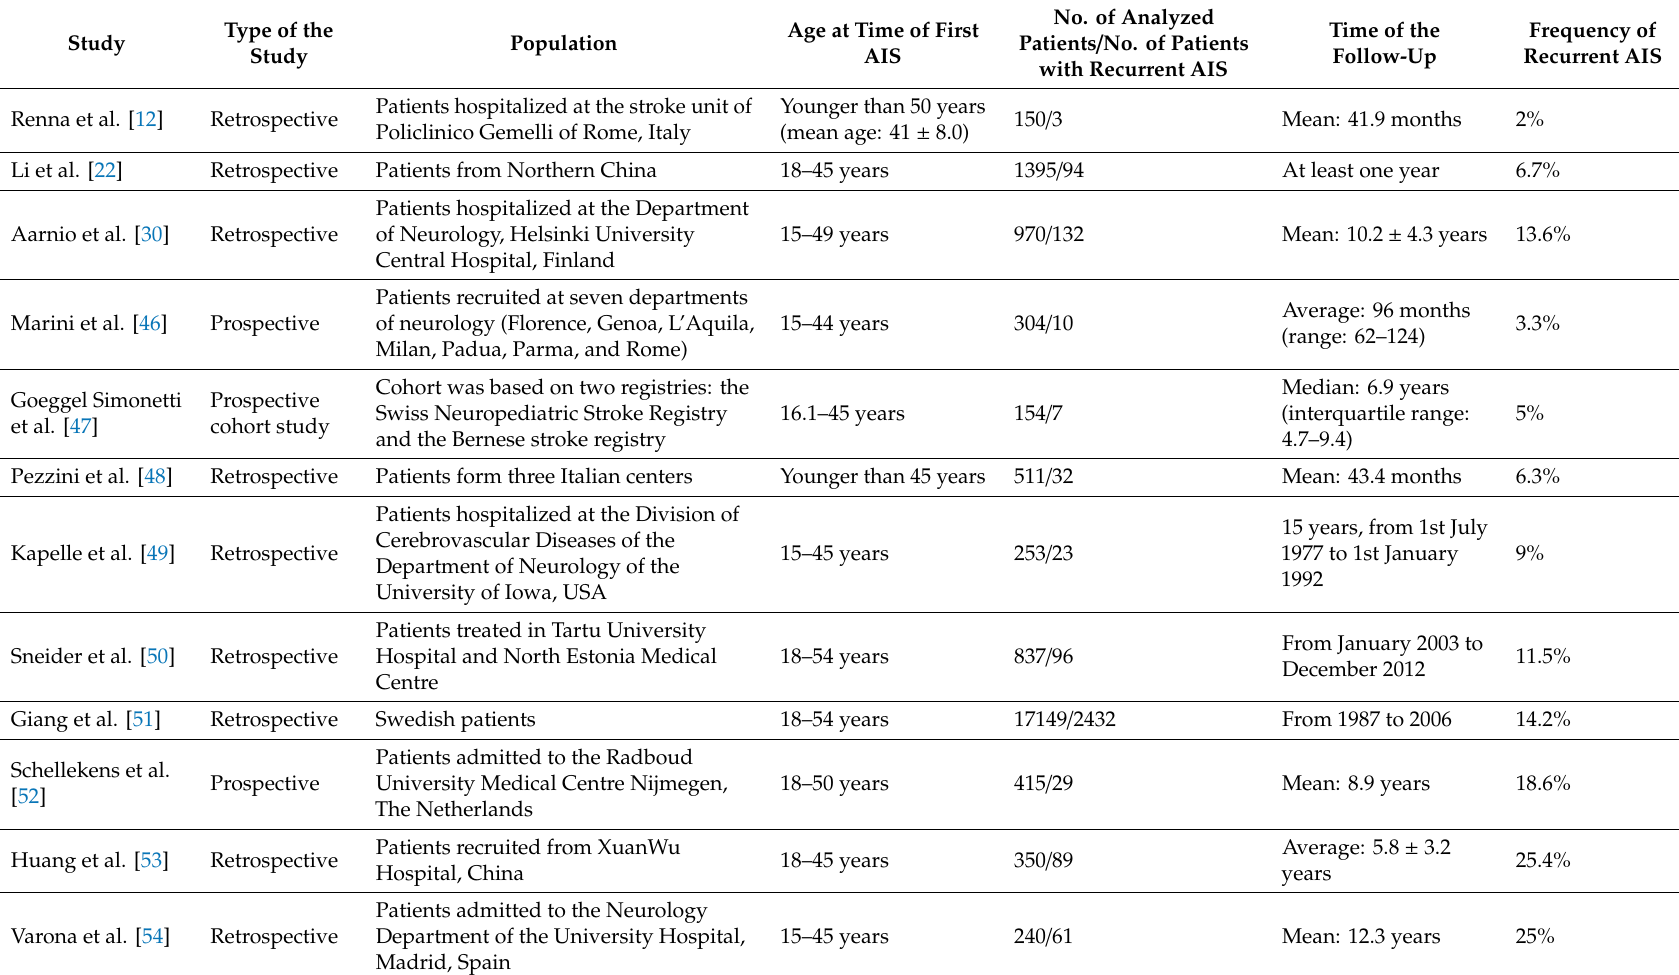
Table 2. Prevalence of AIS recurrence in di ff erent populations of young